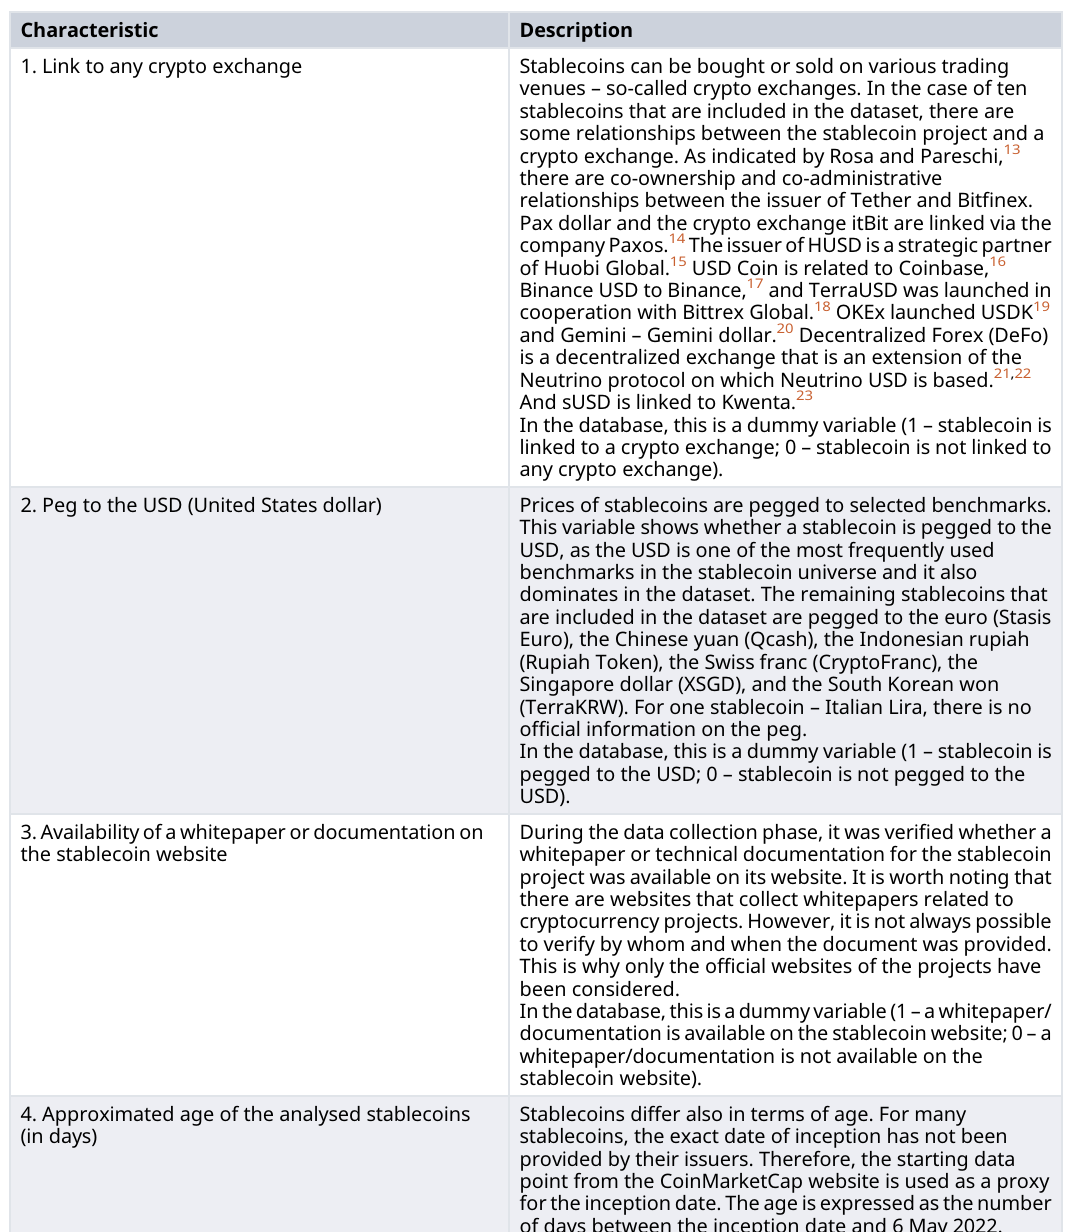
Table 1. Characteristics of stablecoins included in the database and their